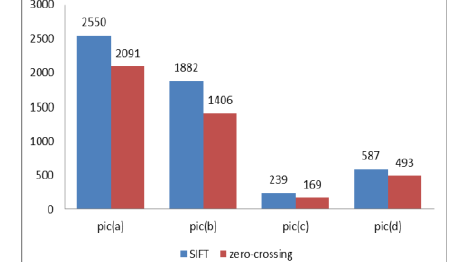
Figure 3(a) number of features by SIFT algorithm and zero- crossing algorithm. Blue bar for SIFT algorithm and red bar for zero-crossing algorithm. The x-axis showed different group of test images and the y-axis stands for the number of features.